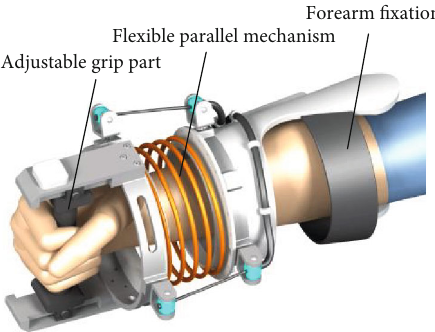
Figure 2: Structure of the fl exible parallel mechanism of the